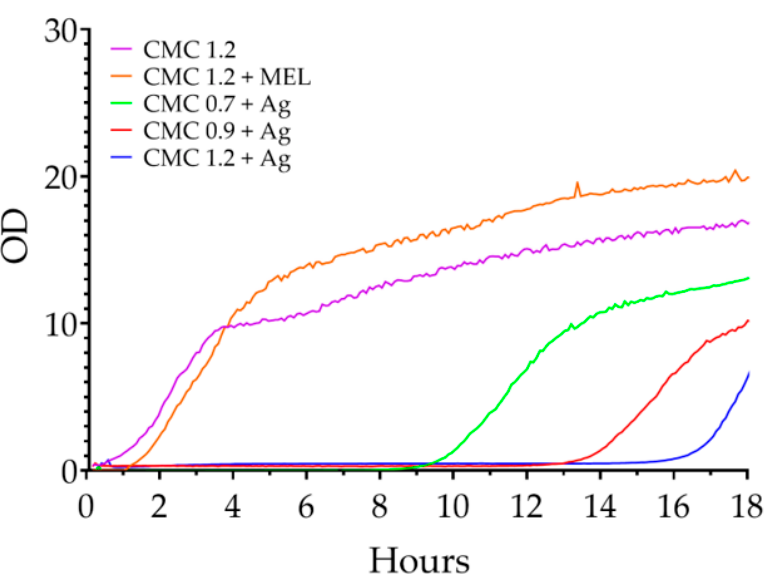
Figure 9. Changes in the optical density of liquid S. aureus cultures in the presence of the films tested. Changes in the optical density of liquid cultures of C. albicans are shown in Figure 10. Here, the onset of logarithmic growth occurred between 3 and 4 h for all samples, except CMC 1.2 + Ag for which this phase began around the 11th hour. Again, this indicates the influence of the degree of substitution on the nanoparticles obtained.